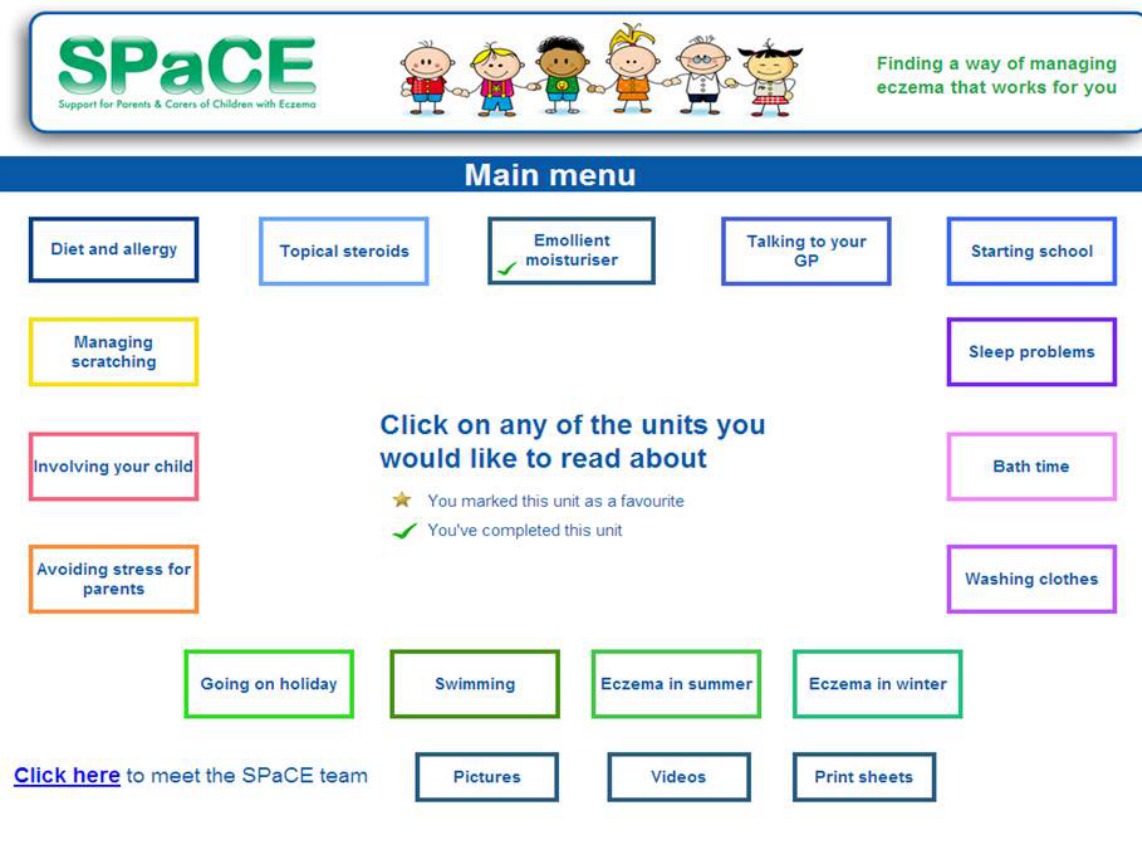
Figure 2. Screenshot of SPaCE menu of